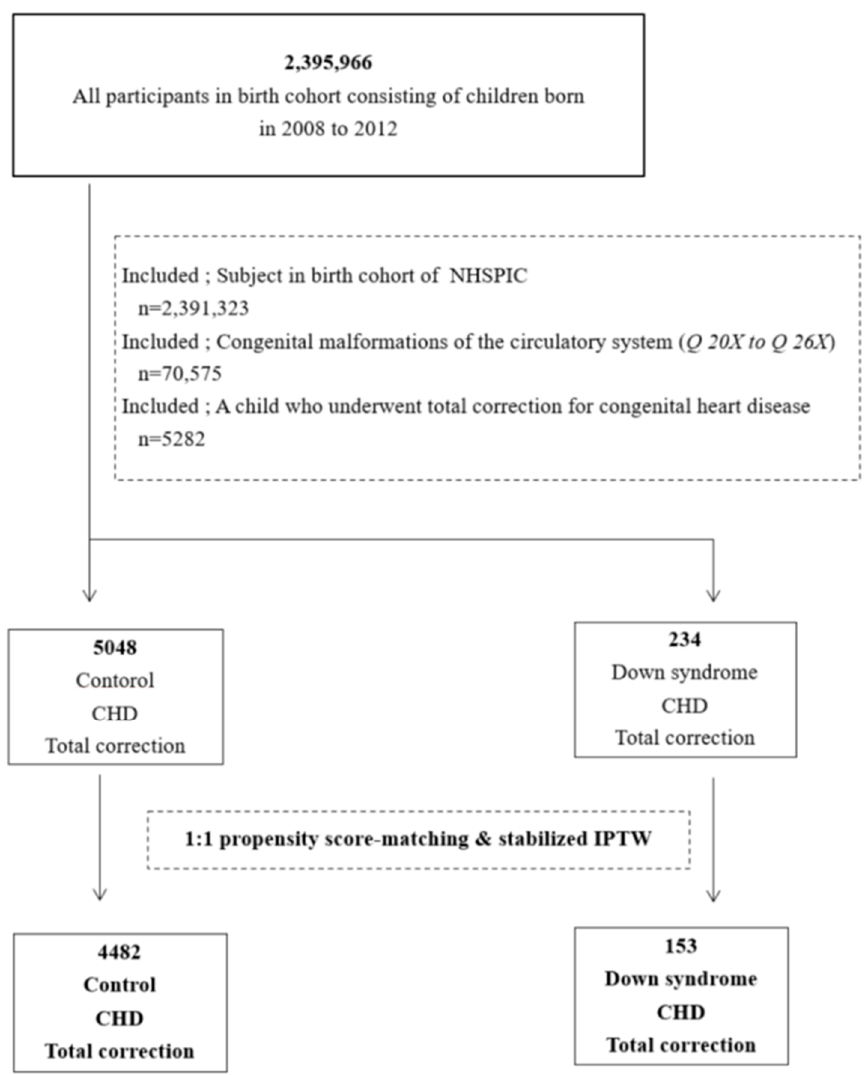
Figure 1. Flowchart of participant selection from the birth cohort. Among the 70,575 children with congenital heart disease, 5282 who underwent total correction were included in the subject group; 234 had Down syndrome and the remaining 5048 were children without Down syndrome. Propensity score matching (maximum 1:1) and stabilized IPTW were performed to assign 153 participants to the Down syndrome group and 4482 participants to the non-Down syndrome group. NHSPIC = National Health Screening Program for Infants and Children, CHD = congenital heart disease, IPTW = inverse probability treatment weighting.